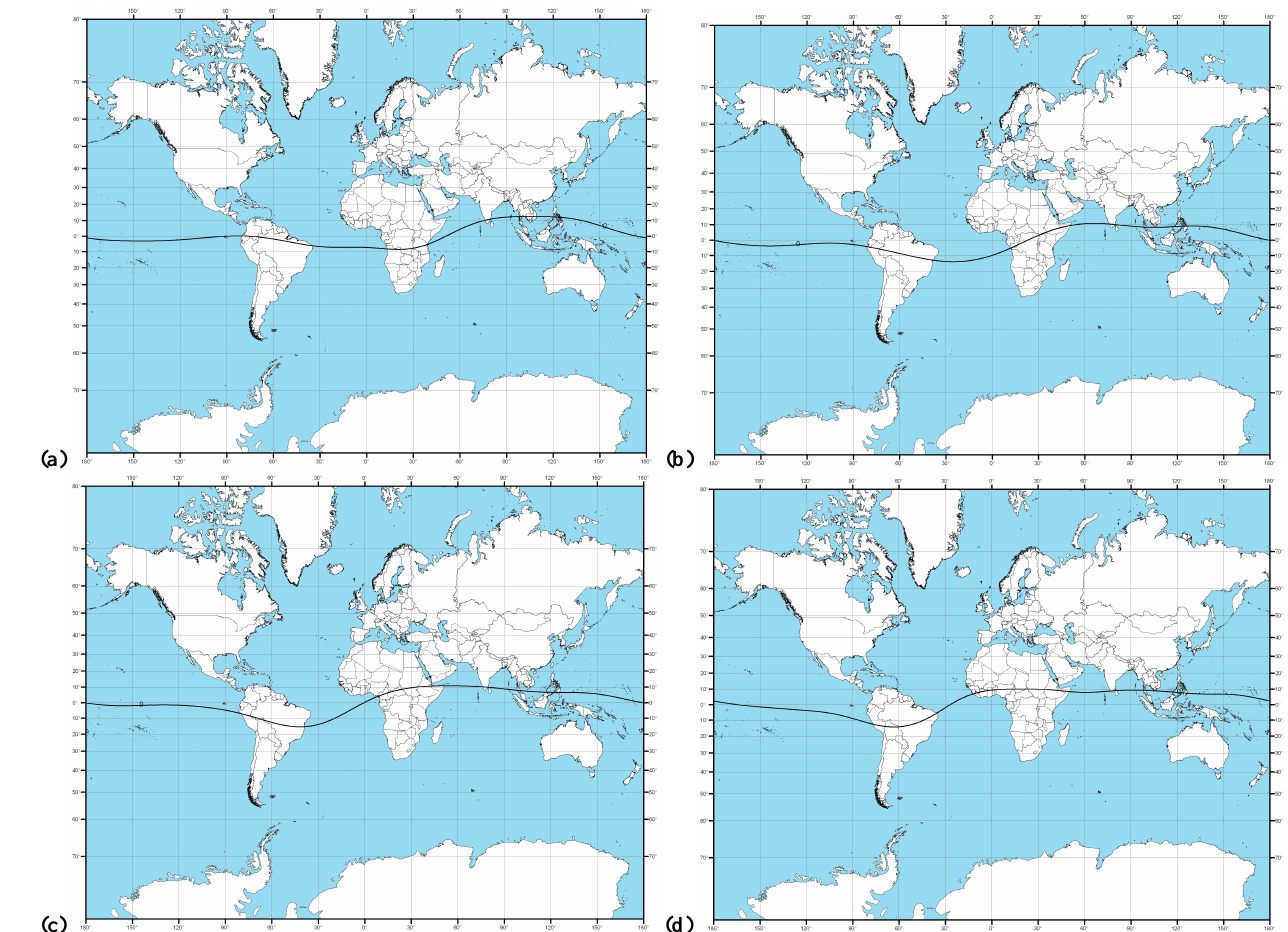
Figure 4. Observed westward drift of a south-west to north-east trending element of the magnetic equator comparing maps for 1650 (a) , 1750 (b) , 1850 (c) and 1950 (d)